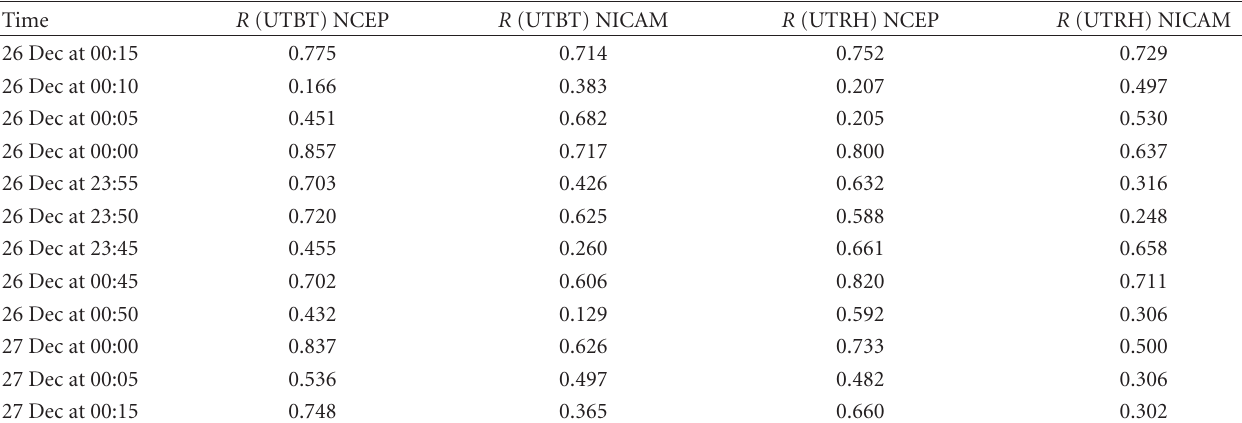
Table 1: Correlation coe ffi cient ( R ) between observed and simulated UTBT (BT6.7) and UTRH during the year 2006. NCEP represents the NCEP/DOE data.